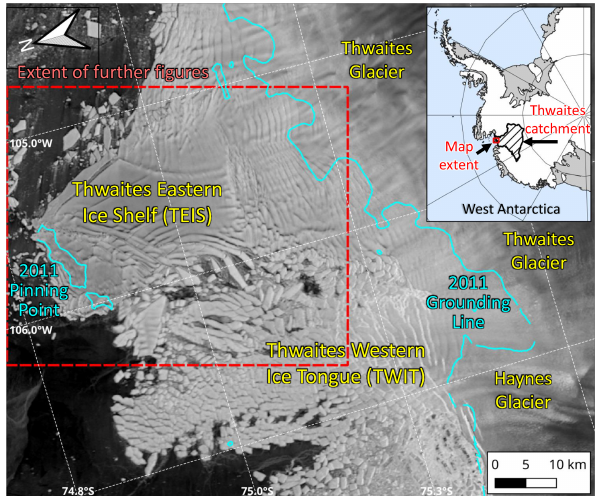
Figure 1. The floating extensions of Thwaites Glacier, showing the location of the Thwaites Eastern Ice Shelf (TEIS), the Thwaites Western Ice Tongue (TWIT), and the position of grounding lines and the location of pinning points in 2011 from Rignot et al.